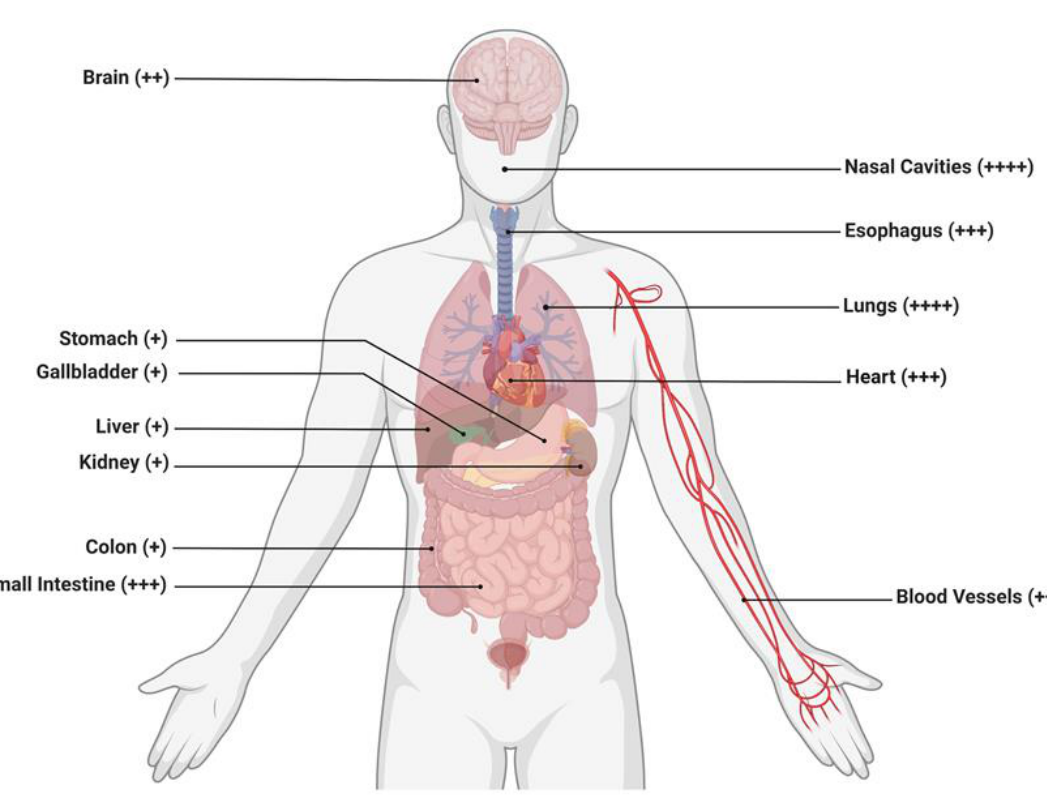
Figure 2: Schematic representation revealing the potential target of the COVID-19 virus or its variants to various organs expressing the ACE2 receptors. The organ/organ systems shown are the brain, stom- ach, gallbladder, liver, kidney, colon, small intestines, nasal cavities, esophagus, lungs, heart, and blood vessels. Different organs with the ACE2 receptor expression are arbitrarily depicted as + (low), ++ (me- dium), and +++/++++ (high), thus, demonstrating the diverse ability of these viruses to infect respective organs and result in clinical negative outcomes for the patient. Retrieved and revised from https://app.bi-